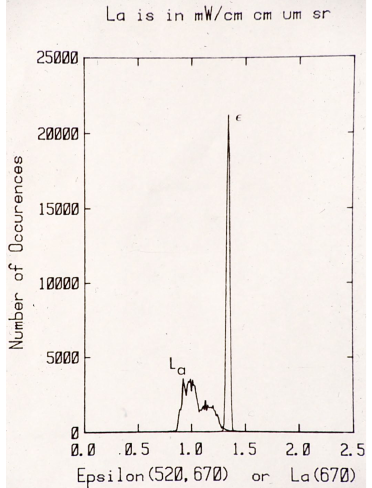
Figure 4. Histogram of the variations L a ( 670 ) and ε ( 520,670 ) from pixels in the box drawn on Figure 3. (Taken from